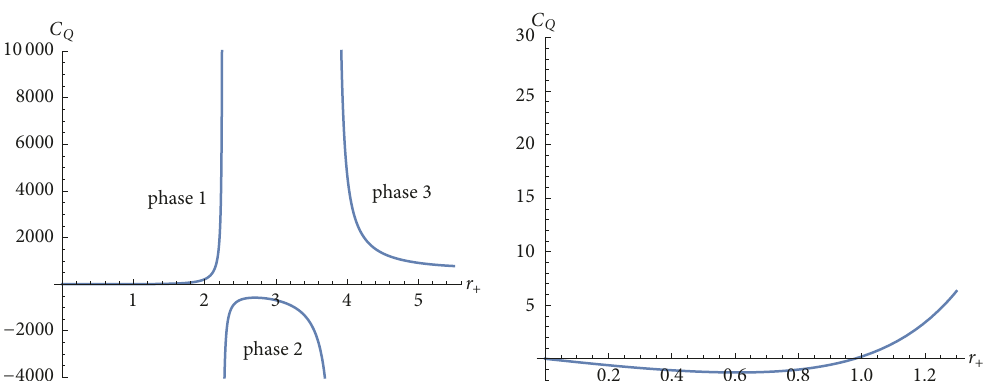
Figure 3: 𝐶 푄 − 𝑟 + diagram of charged AdS black holes in the rainbow gravity. It corresponds to 𝑙 = 8 , right one corresponds to an extending part of near 𝑟 + = 1 . We have set 𝜂 = 1 , 𝑄 = 1 , 𝑚 = 0